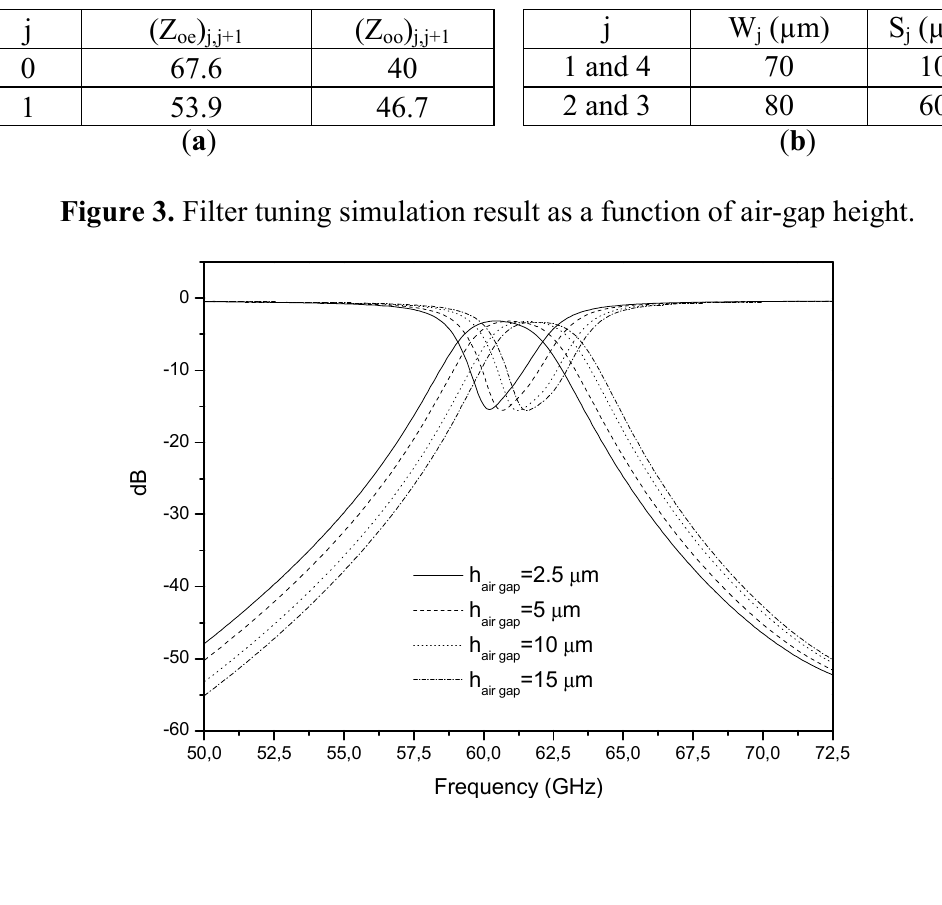
Table 1. Design parameters of the bandpass filter. ( a ) Even- and odd-mode impedance of coupled microstrip lines. ( b ) Coupled microstrip dimensions of the filter.